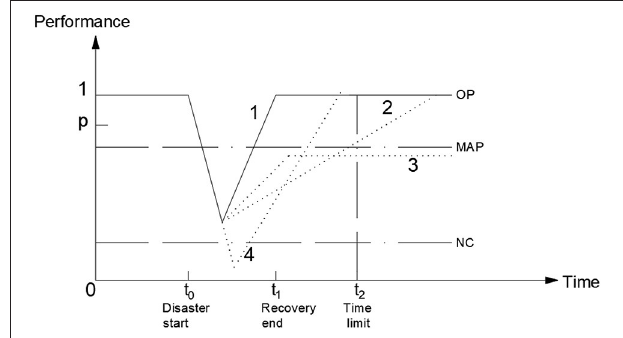
FIGURE 3 | First order failure propagation from different networks to the transportation network.